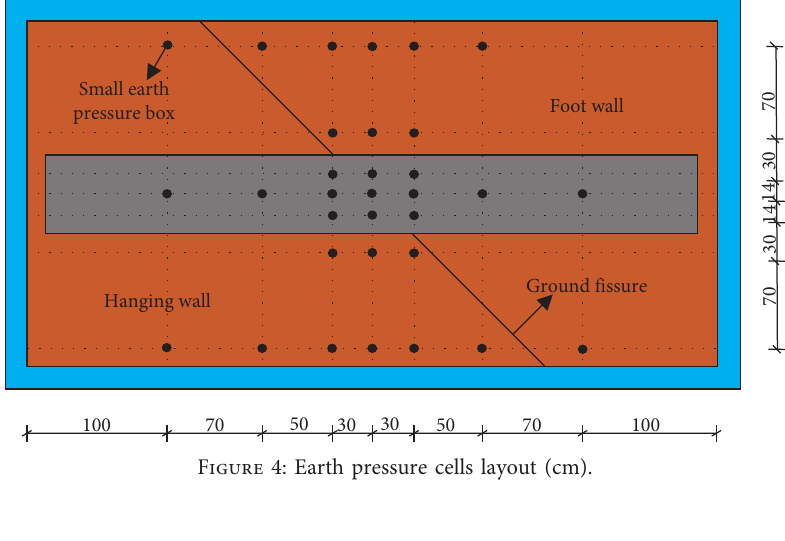
Figure 4: Earth pressure cells layout (cm).